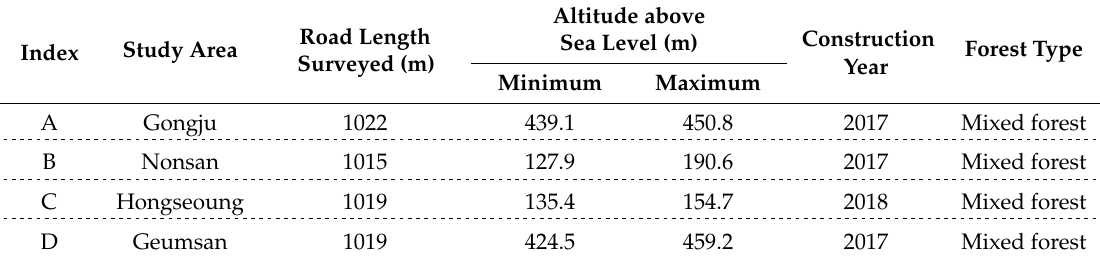
Figure 2. Locations of the study sites. Table 1. General characteristics of the study sites.